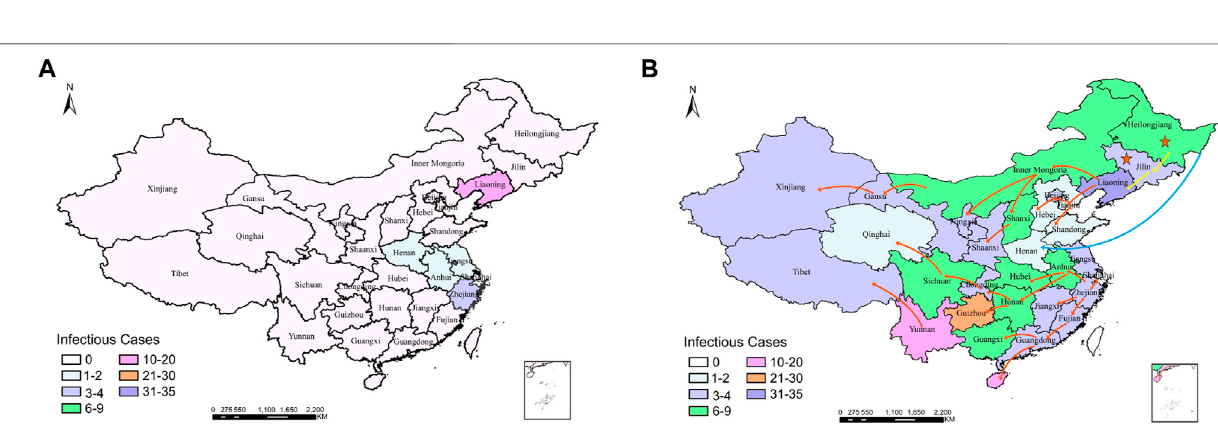
Frontiers in Physics |